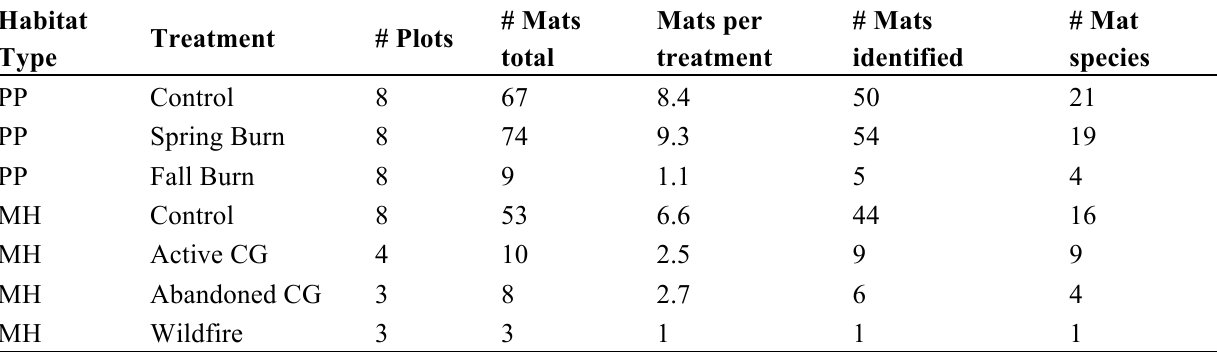
Table 1 . Number of mats located and identified by DNA analysis, by treatment. PP = ponderosa pine habitat; MH = mountain hemlock habitat; CG = campground.